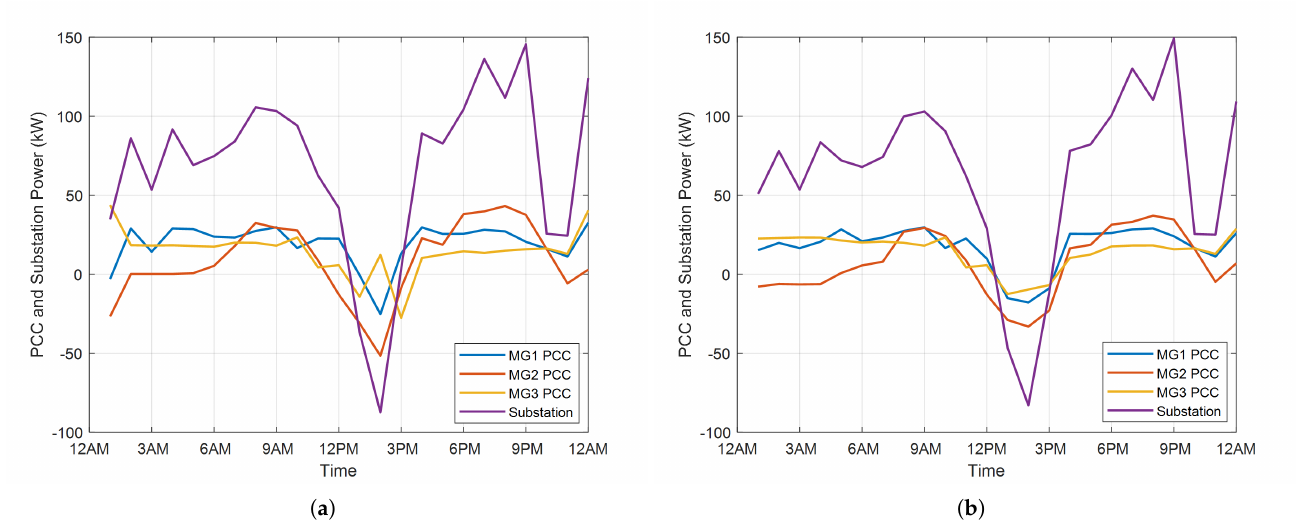
Figure 5. PCC and substation power in grid-connected mode. ( a ) Centralized Method. ( b ) Distributed